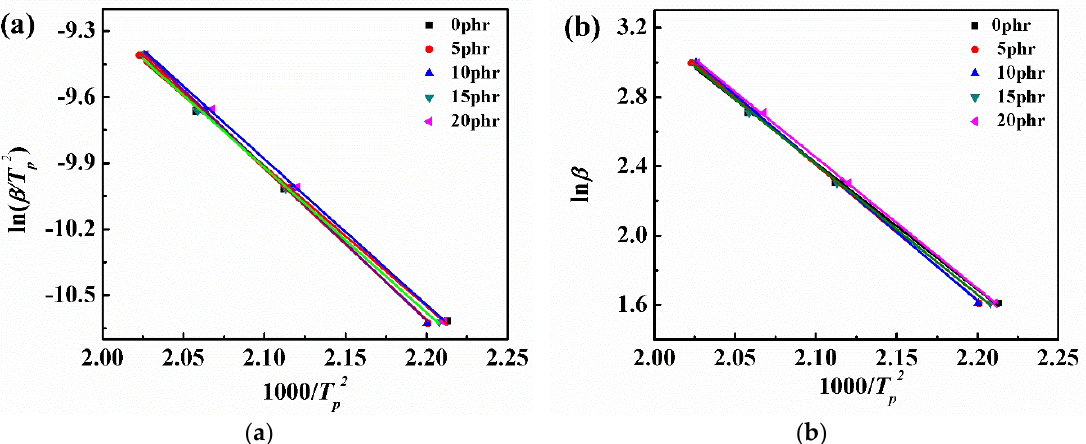
Figure 3. Plots for determining the activation energy of the curing reaction by Kissinger equation ( a ) ln(β/ T p 2 ) vs. 1000/ T p , ( b ) ln β vs. 1000/ T p